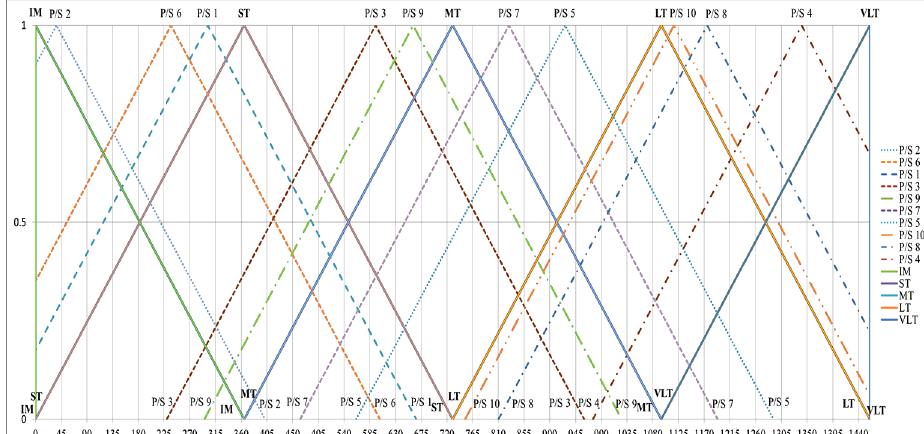
Figure 6. Graphical representation of the launch of products/services according to the strategic